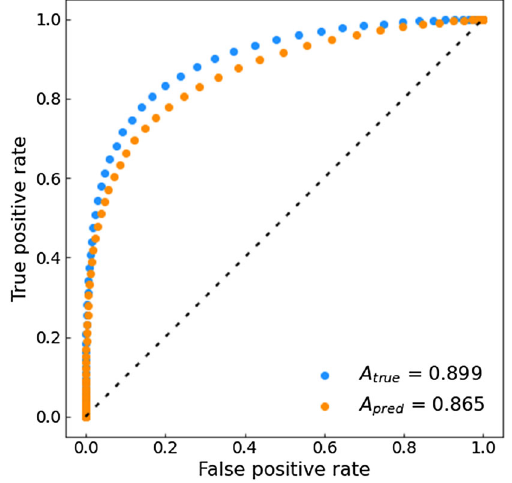
Fig. 4 True (blue) and predicted (orange) ROC curves and their asso- ciated areas under curve, A true and A